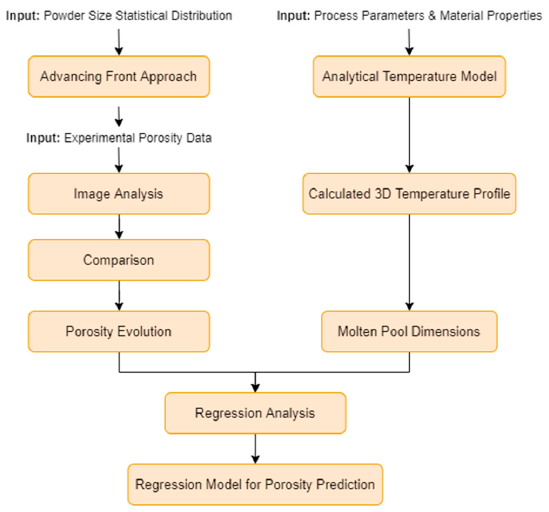
Figure 8. Schematic illustration of the algorithm used in the porosity prediction model. Adapted from [58], with permission of Elsevier, 2020.